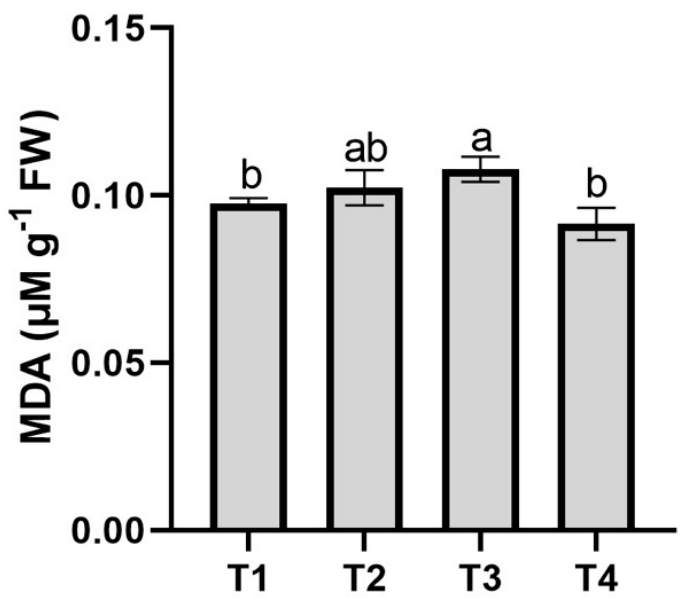
Figure 2. MDA concentration in spears from the four different plots: untreated control (T1), Brassica pellets (T2), chicken manure pellets (T3), and Dazomet (T4). Values are expressed as means ± standard error ( n = 9). Bars marked with different letters indicate significant differences among genotypes based on the LSD 0.05 test ( p < 0.05).